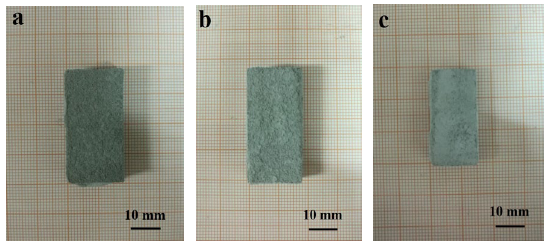
Fig. 1 Macro morphologies of 3D-printed porous Si 3 N 4